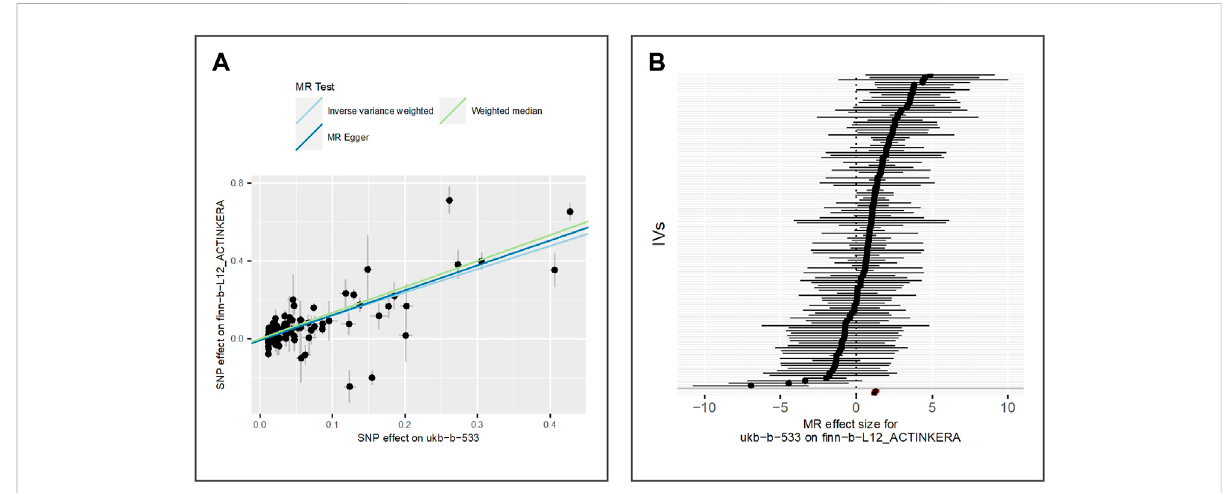
FIGURE 2 Comparison of MR methods and results associated with actinic keratosis. (A) Scatter plot re fl ects SNP effects on the actinic keratosis against SNP effects on the exposure; (B) forest plot represents the causal effect of exposure on the outcome using each SNP singly.